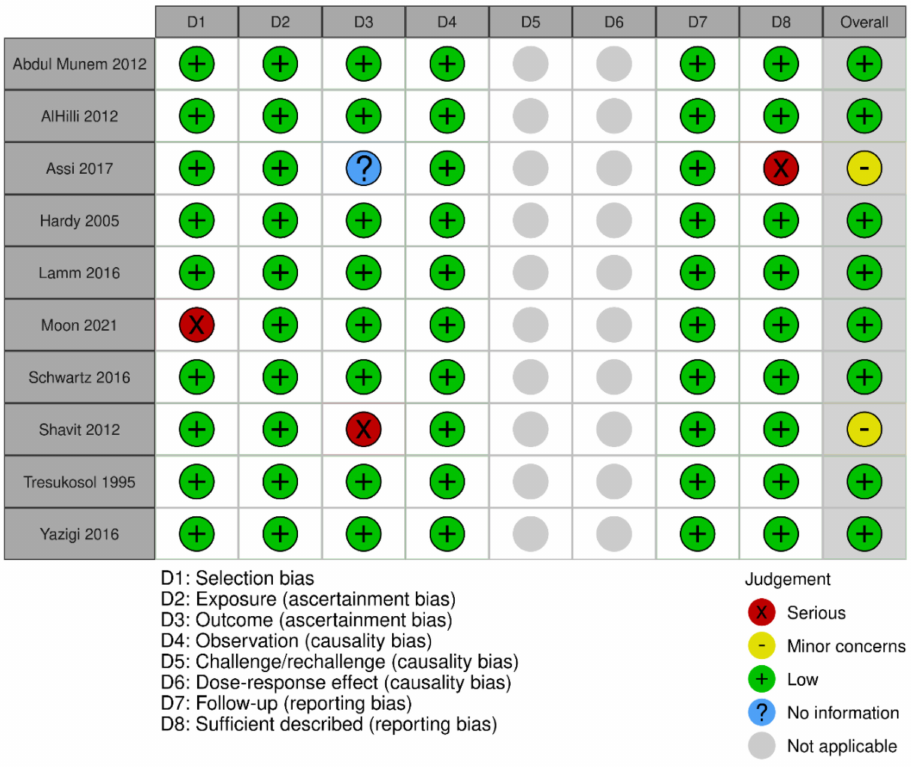
Figure A3. Risk of bias results in case reports using Murad’s tool